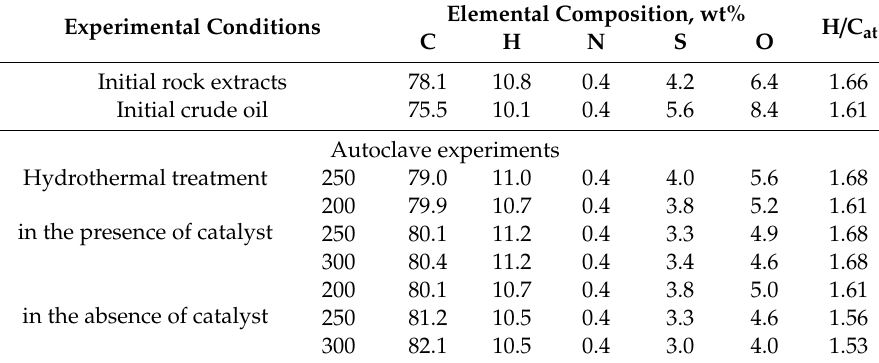
Table 2. Elemental composition of rock